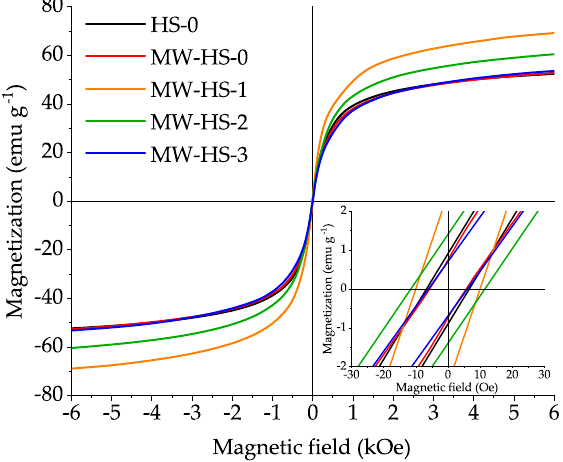
Figure 5. Magnetization curves of the prepared samples (inset shows a low-field region of magnetization curves to identify the coercivity and retained